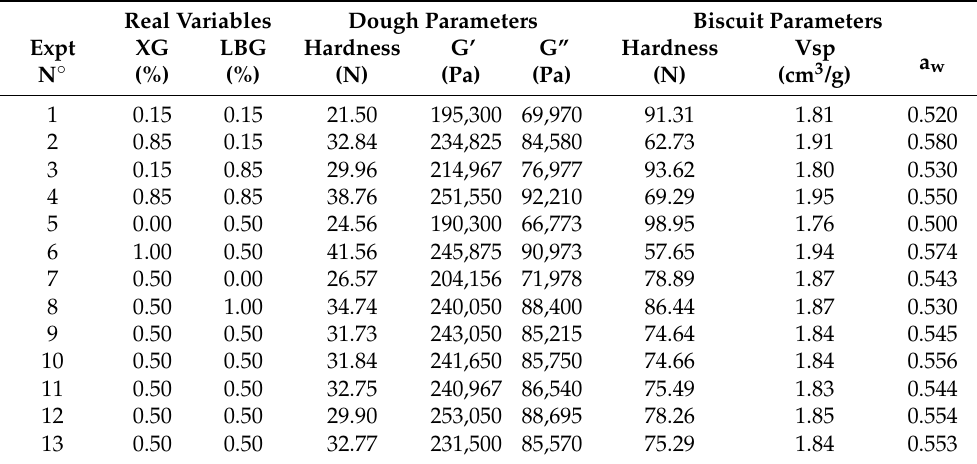
Table 1. Experimental design matrix for rice–chickpea composite flour (R–CPF) biscuit manufacture. Real Variables Dough Parameters Biscuit Parameters Expt